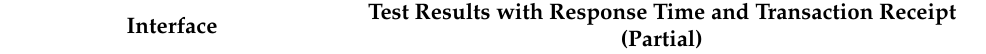
Figure 13. Test result from Get TPGU Access Token function call. Table 5. Response Times and TX receipts (partial) for update interfaces in